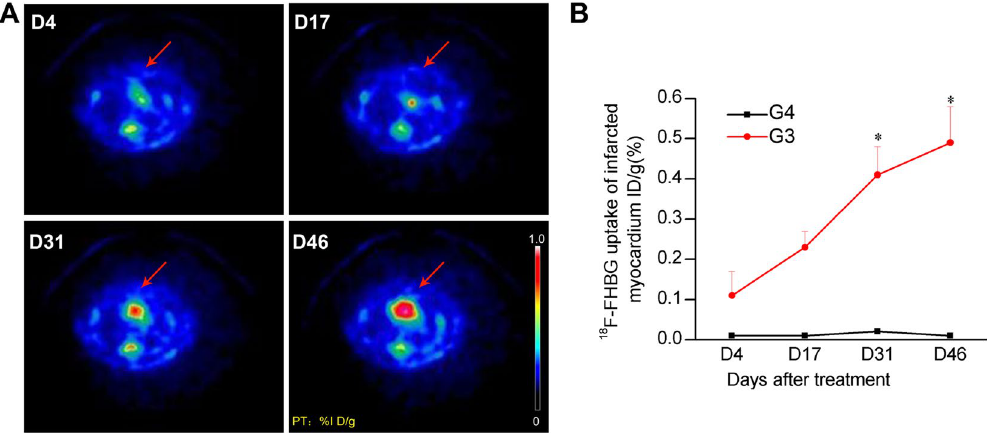
Figure 4. 18 F-FHBG imaging and uptake analysis of BMSCs in a rat model of MI. ( A ) Transverse 18 F-FHBG microPET/CT images of BMSCs (red arrows) in the transplant region 4, 17, 31, and 46 days after treatment. ( B ) Quantification of 18 F-FHBG uptake in infarcted myocardium (% ID/g). G4, untransfected-BMSC-treated MI model. * P < 0.05 vs. G3, transfected-BMSC-treated MI